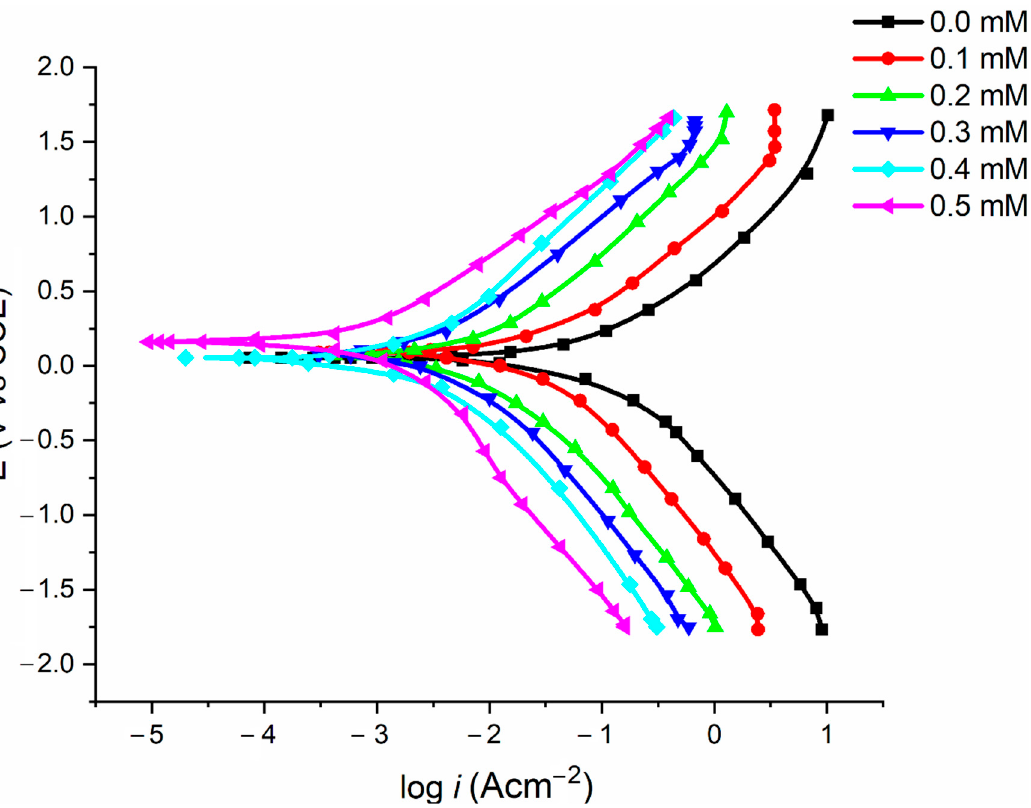
Figure 7. Polarization curves of mild steel samples in acidic media with various concentrations of nicotinehydrazide derivative. Table 1. Tafel parameters for mild steel samples in acidic media with and without various concentra- tions of nicotinehydrazide